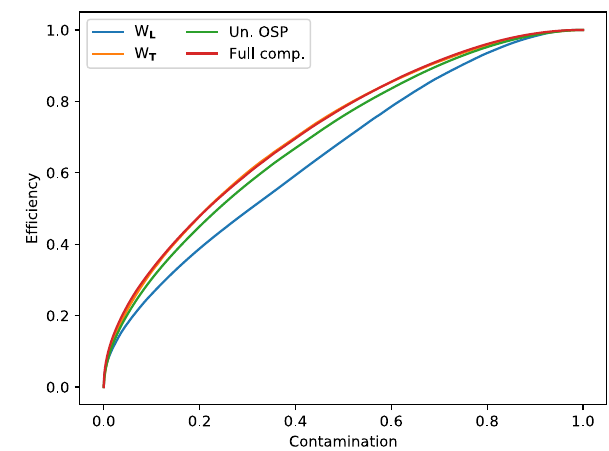
Fig. 7 The DNN binary classification score in the semi-leptonic chan- nel, determining the appropriate sign to use in neutrino momentum reconstruction is shown separately for events with true positive and true negative solutions, evaluated on events with transverse W polarization. The DNN model is composed of 4 hidden layers and 60 neurons in each of them, the training was performed on an unpolarized PHANTOM sample. The sharp peak at 0.5 represents events for which the classifier cannot make a decision